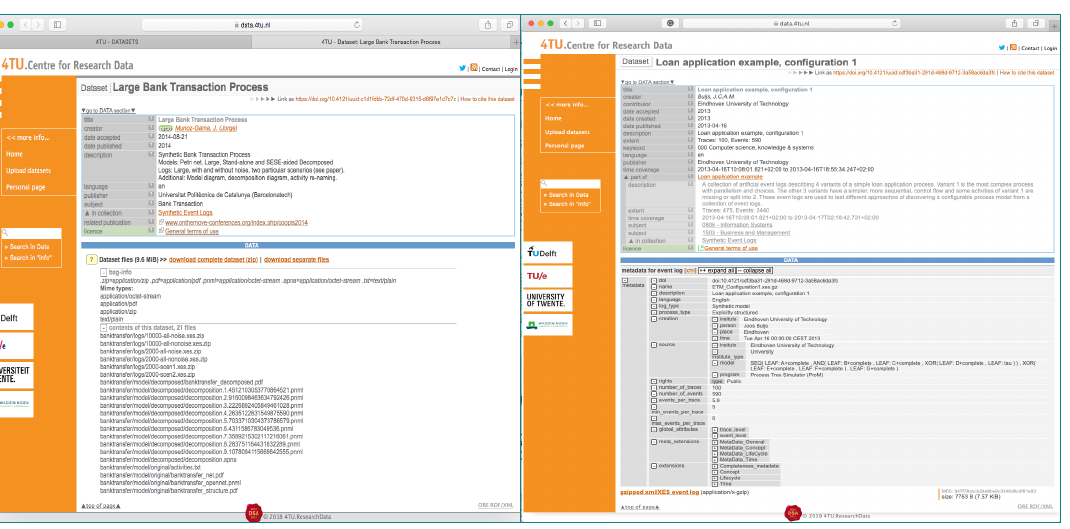
Figure 9. The detailed descriptions of the datasets from the 4TU.Centre for Research